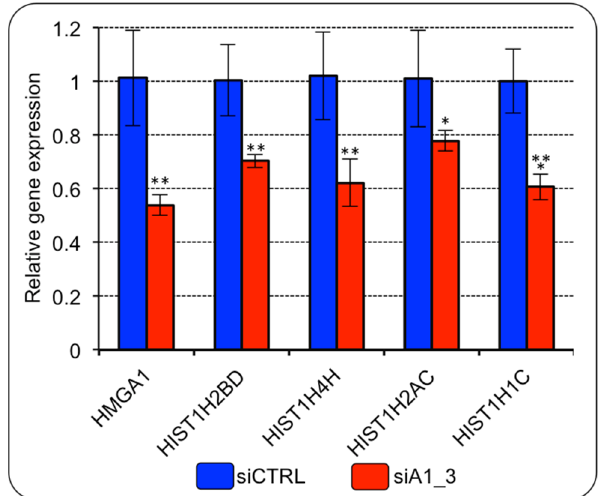
Figure 3. HMGA1 regulates the expression of histone genes belonging to HIST1 in MDA-MB-231 cells. RT-qPCR gene expression analyses of four genes of the RD-HIST module in MDA–MB–231 cells silenced for HMGA1 (siA1_3) or treated with control siRNA (siCTRL). The levels of HMGA1 expression are included in the panel as control for silencing efficiency. Bars indicate the mean. Standard deviations are shown ( n = 4). Statistical significance was assessed with Student’s t test (*: p ≤ 0.05; **: p ≤ 0.01; ***: p ≤ 0.001).